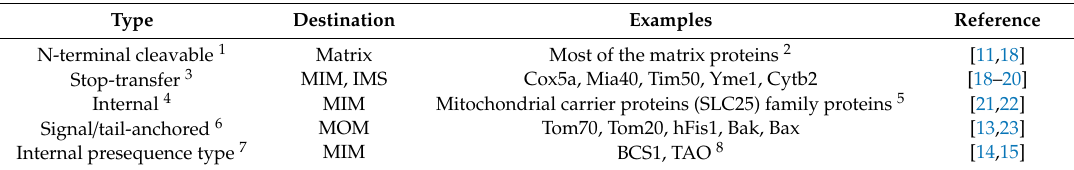
Table 1. Di ff erent types of mitochondrial targeting